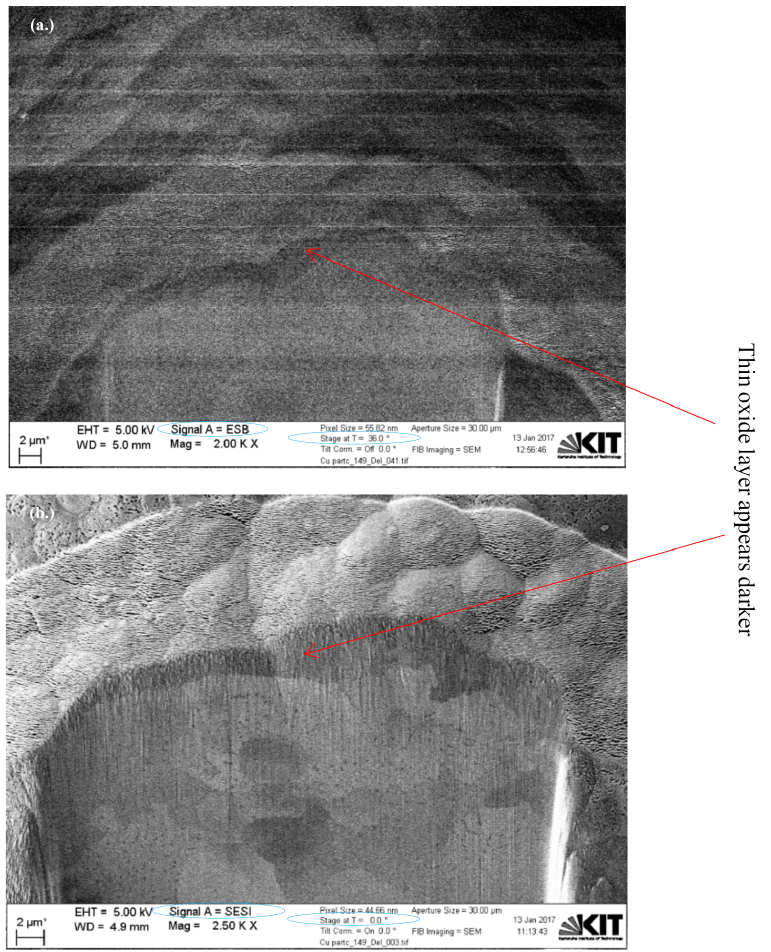
Figure 6. Dual FIB-SEM sectioned images of Cu particles with less than 149 µ m using ( a ) BSE and ( b ) SESI modes for